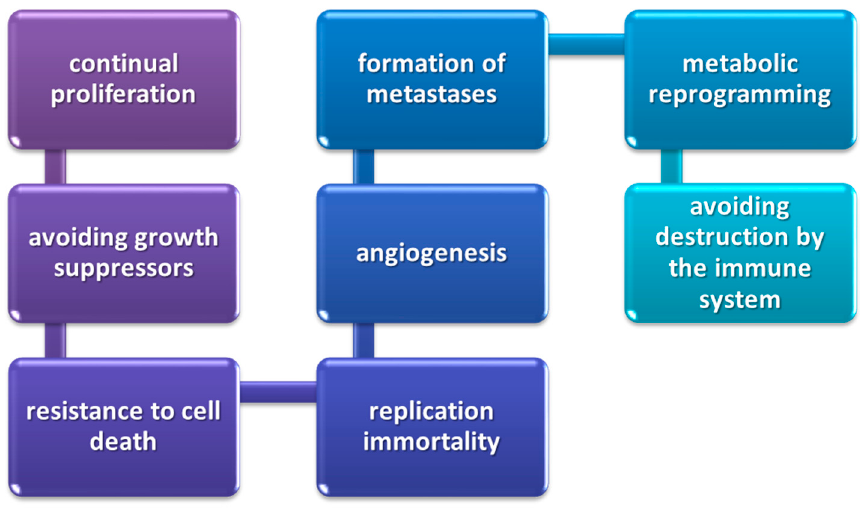
Figure 3. Stages of cancerogenesis development and progression (based on [300]).